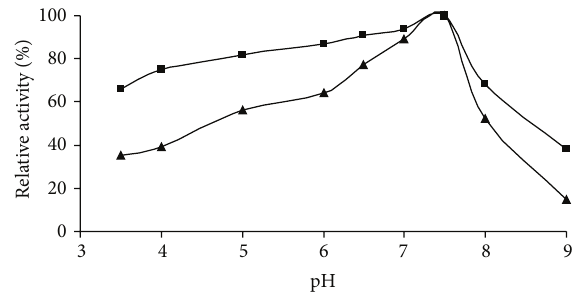
Figure 1: Effect of pH on activity: ( 󳵳 ) free PPO and ( ◼ ) immobilized PPO.